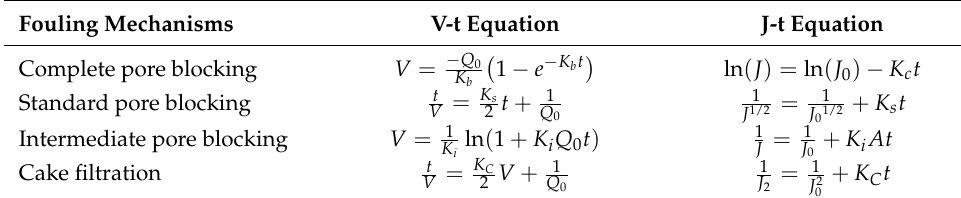
Table 1. Hermia’s model (fouling mechanisms). Fouling